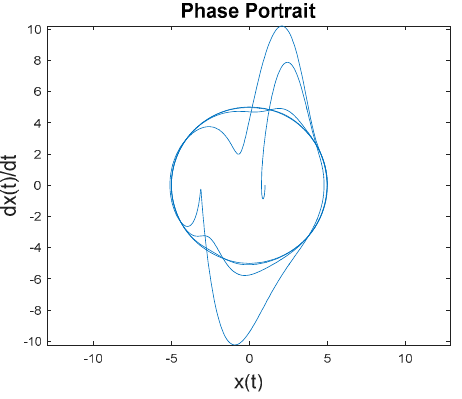
Figure 7. Commanding a desired trajectory as a circle of radius five using idealized feedforward control.